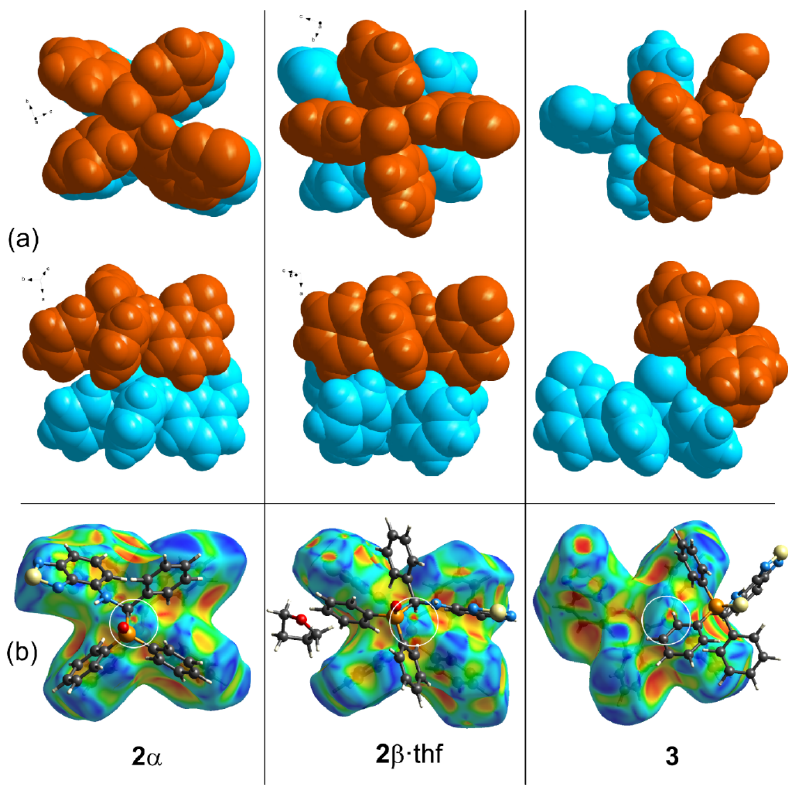
Figure 3. ( a ) Space-filling representation of two molecules of 2 α , 2 β ·thf, and 3 in two orientations ( b ) Hirshfeld surface for the corresponding molecules with plotted Shape Index colours: red—concave, blue—convex, green—flat. White circles highlight a convex induced by the O or S atom at the phosphine group. Sulphide and selenide compounds 3 and 4 are isostructural with each other crystal-